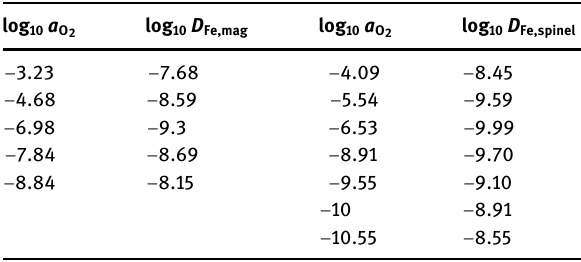
Table 2: Logarithm of iron di ff usion coe ffi cients measured